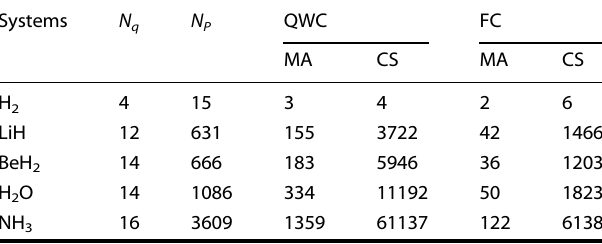
Table 4. Variances of Hamiltonian estimators with fully commuting fragments.